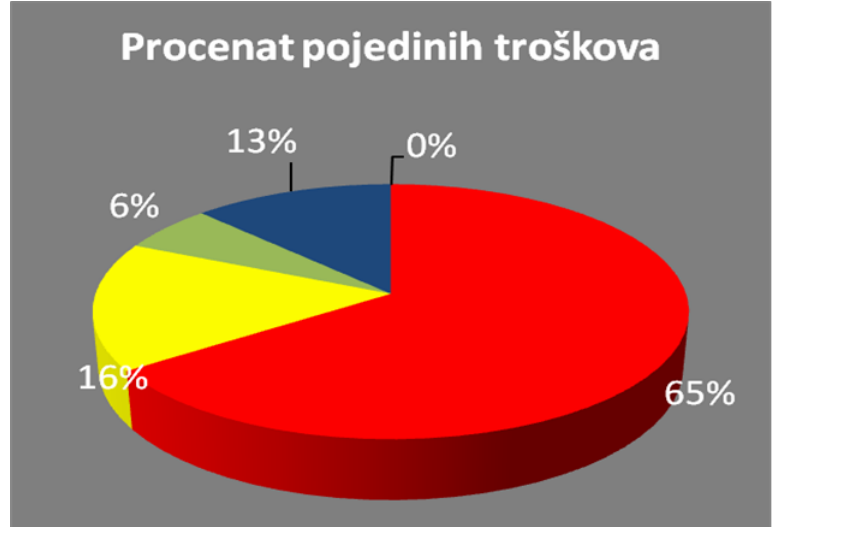
Figure 5 – Percentage of cost categories in overall asset costs during the life cycle, with 50% increased reliabillity of the asset